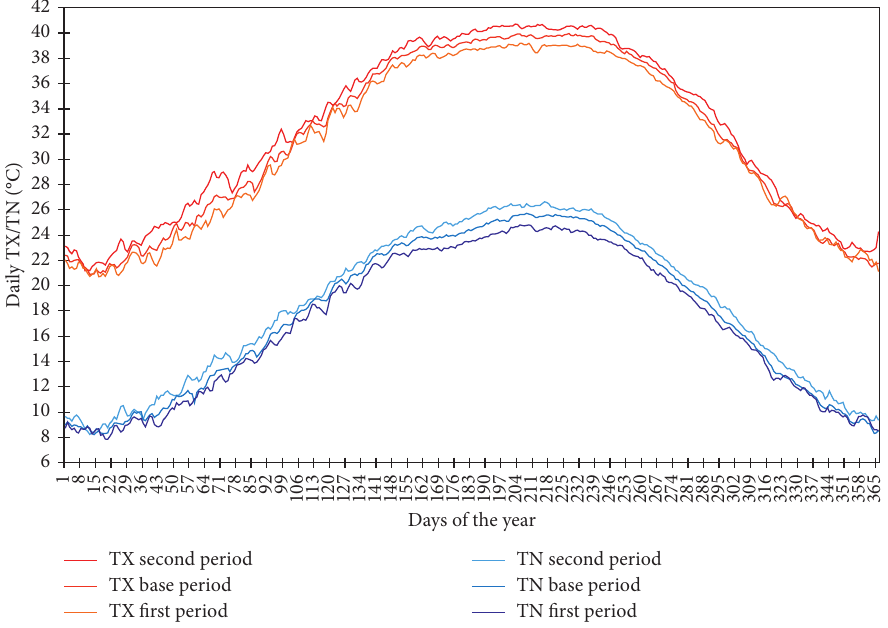
Figure 6: Daily values of the maximum (TX, upper curves) and minimum (TN, lower curves) temperature for the base period (1981–2010, bold lines) along with the first period (1981–1999) and the second period (2000–2019) (thin lines) averaged over the